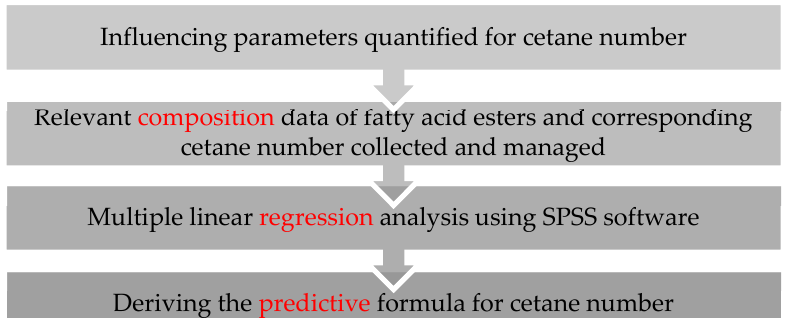
Figure 1. Procedures for deriving the predictive formula for the cetane number of biodiesel.